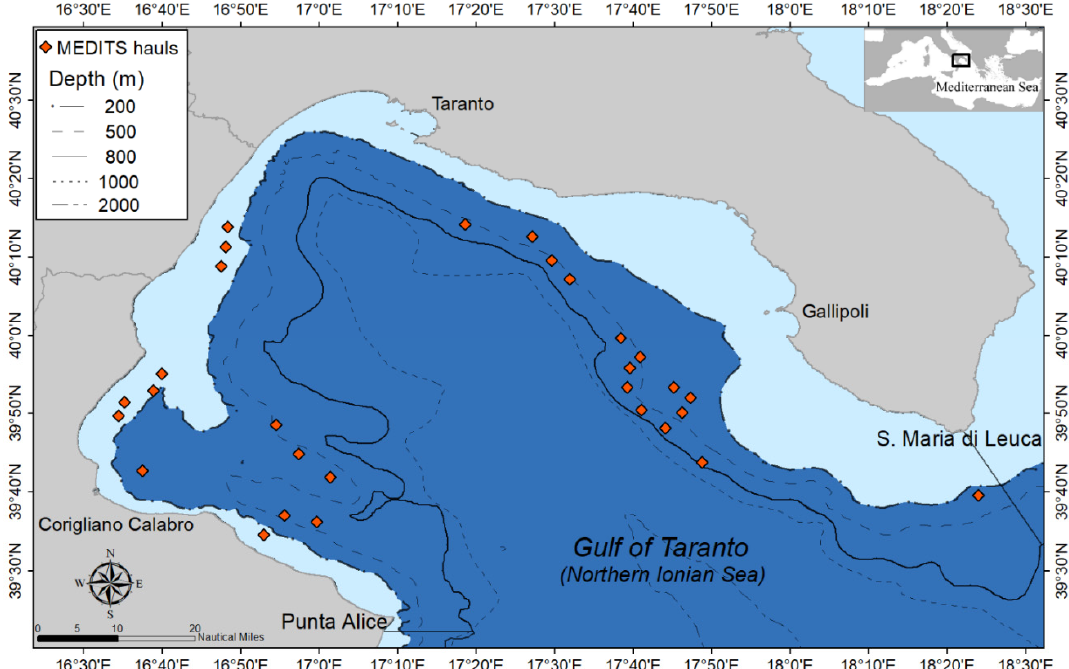
Figure 1. Map of the Gulf of Taranto with the MEDITS experimental trawl hauls and the modelled area included in the black line (800 m of depth). The depth of 200 m separates shelf (light) and slope areas (dark).